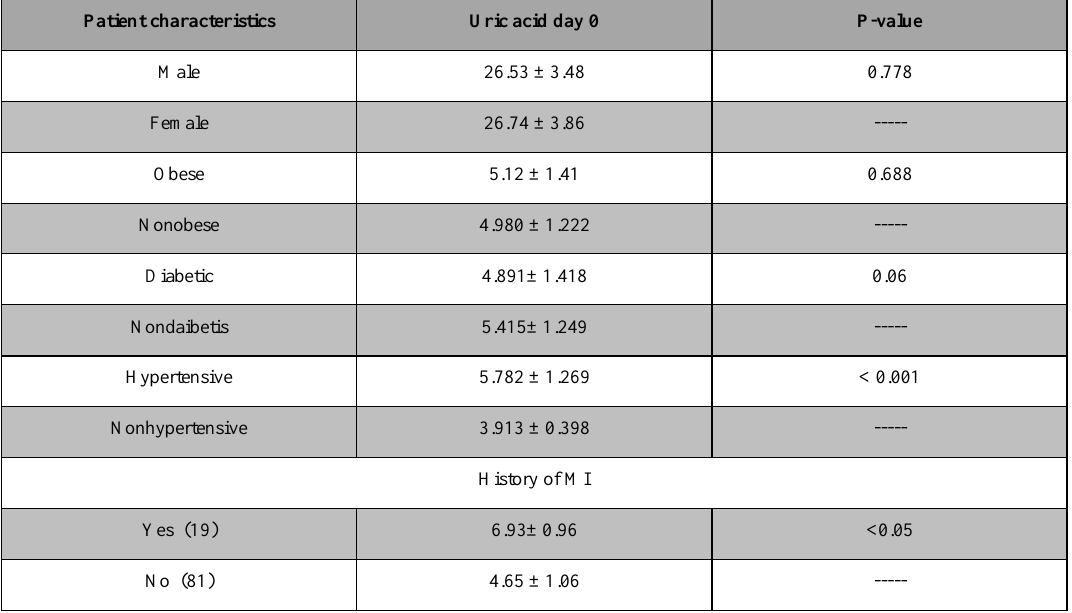
Table 1. Uric acid levels in patients with different ECG diagnoses.